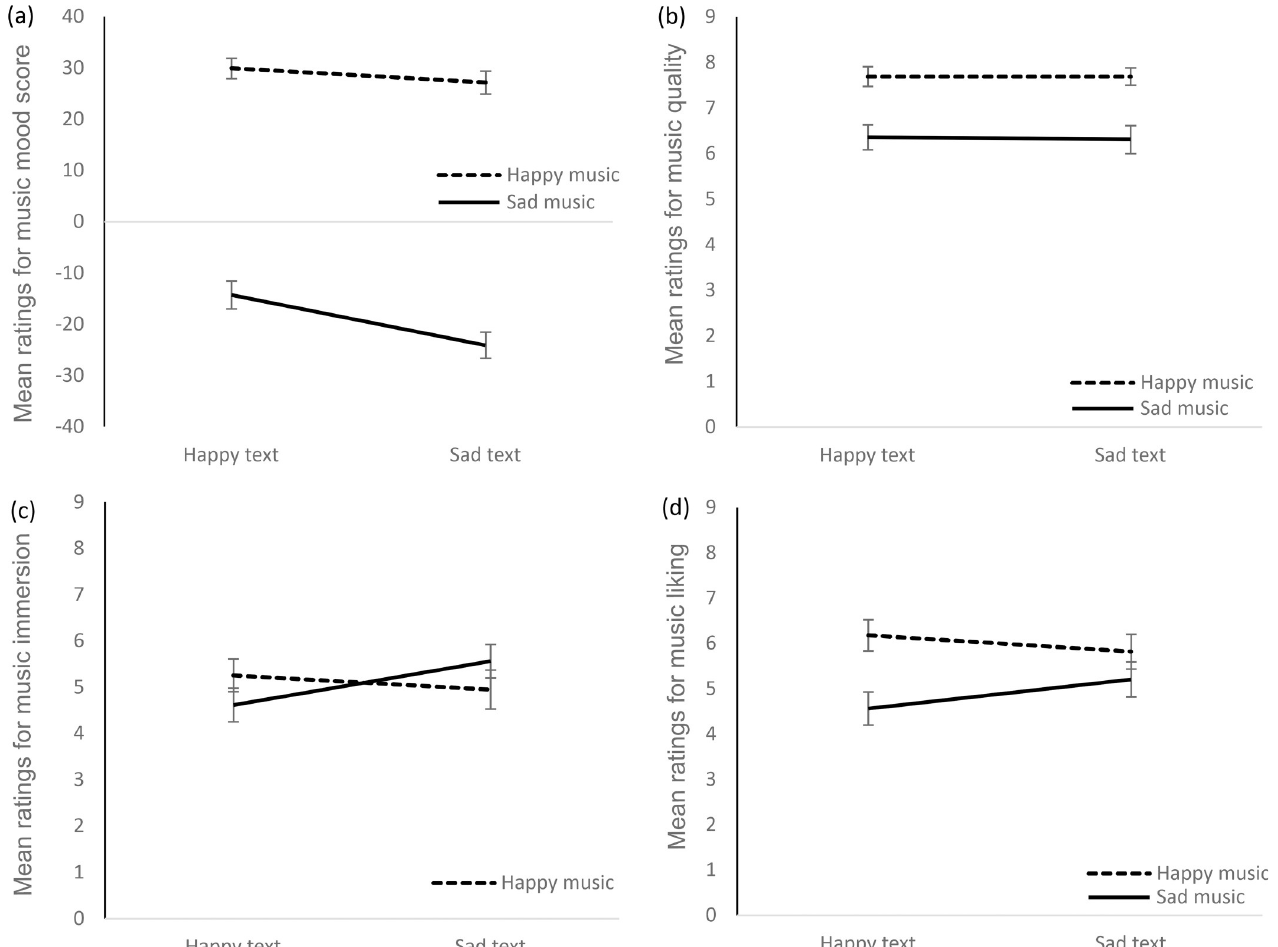
Fig 4. Means for perceived mood score (a), artistic quality (b), immersion (c), and liking (d) of the music as a function of happy vs. sad music and text categories. Error bars show ± 1